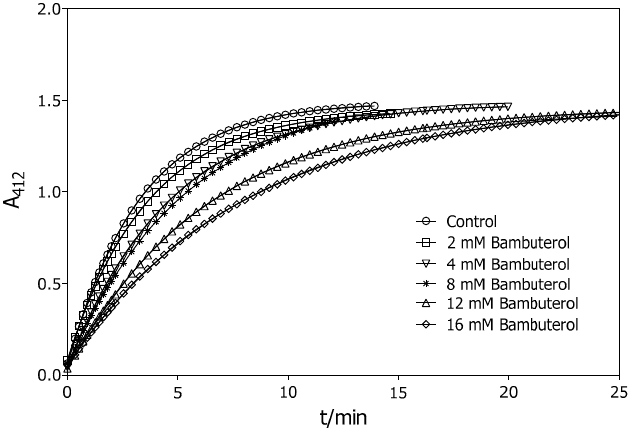
Figure 5. Progress curves for the hydrolysis of PTA by rePON1 in the absence (control) and in the presence of bambuterol (2 mM, 4 mM, 8 mM, 12 mM and 16 mM). The full lines represent theoretical curves calculated using Equation